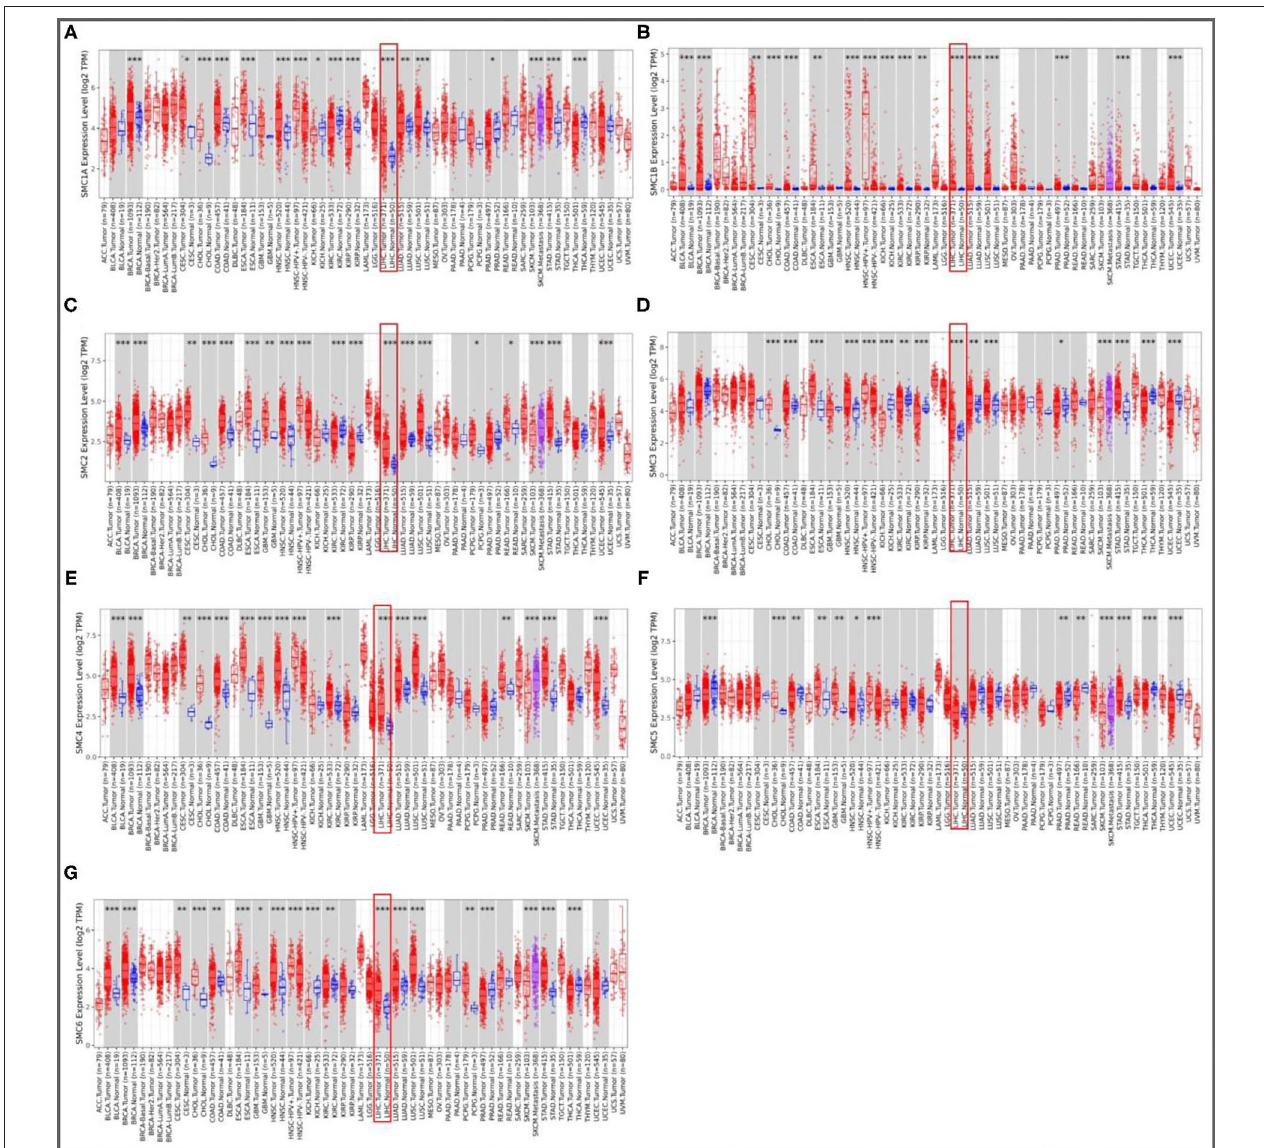
FIGURE 1 | Expression levels of SMC family members in HCC. (A-G) Relative expression of SMC1A , SMC1B , SMC2 , SMC3 , SMC4 , SMC5 , and SMC6 in different cancers compared with normal tissues by the TIMER database. * P < 0.05, ** P < 0.01, *** P < 0.001 compared with control.